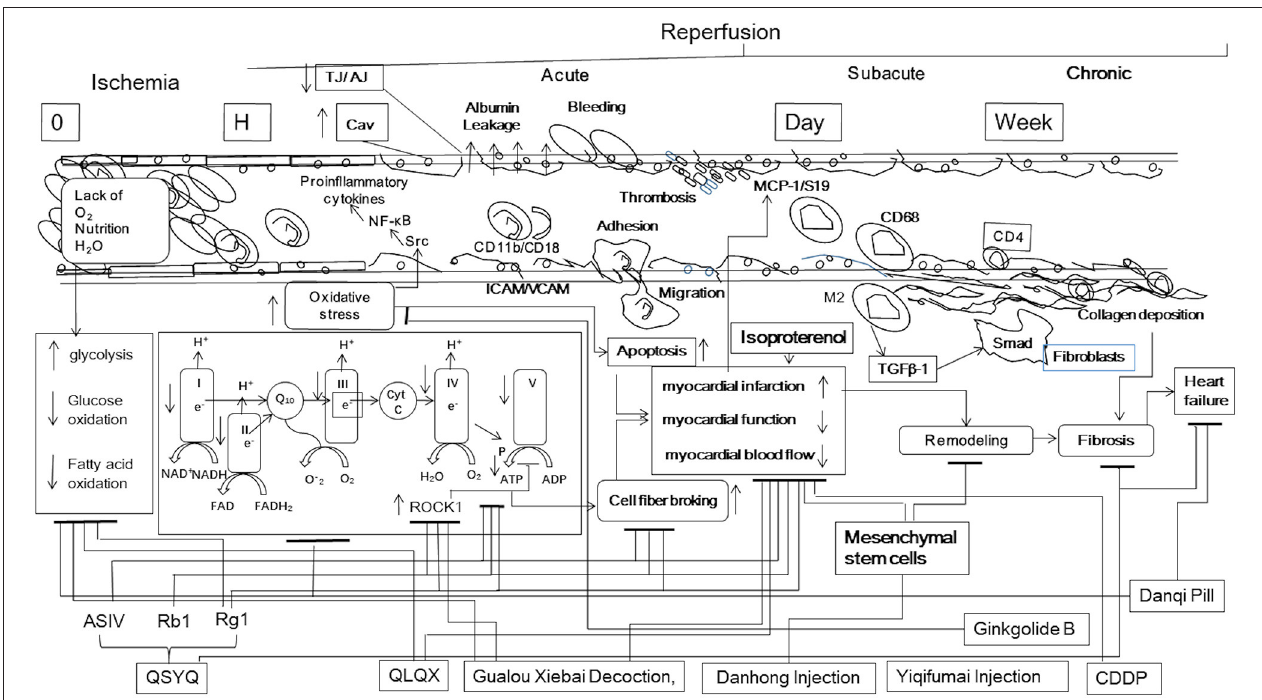
FIGURE 1 | I/R-induced microcirculatory disturbance and tissue injury stepwise progress involving the ischemia, acute, subacute, and chronic phases after reperfusion. Some TCM showing attenuation effect on I/R-induced microcirculatory dysfunction and tissue injury at various phases. I, mitochondrial complex I; II, mitochondrial complex II; III, mitochondrial complex III; IV, mitochondrial complex IV; V, mitochondrial complex V; ADP, adenosine diphosphate; AJ, adhesion junction; ASIV, astragaloside IV; ATP, adenosine triphosphate; Cav, caveolae; CDDP, compound danshen dripping pills; Cyt C, cytochrome c; FAD, flavin adenine dinucleotide; ICAM, intercellular adhesion molecule; M2, M2 macrophages; MCP-1, monocyte chemotactic protein 1; NAD, nicotinamide adenine dinucleotide; NF- κ B, nuclear factor kappa-B; Q10, Coenzyme Q10; QLQX, QiLiQiangXin capsule; QSYQ, QiShenYiQi; Rb1, Ginsenoside Rb1; Rg1, Ginsenoside Rg1; ROCK, Rho-associated kinase; S19, ribosomal protein S19; TGF- β 1, transforming growth factor- β 1; TJ, tight junction; VCAM, vascular cell adhesion molecule. ↑ , increase; ↓ , decrease; ⊥ , inhibition.